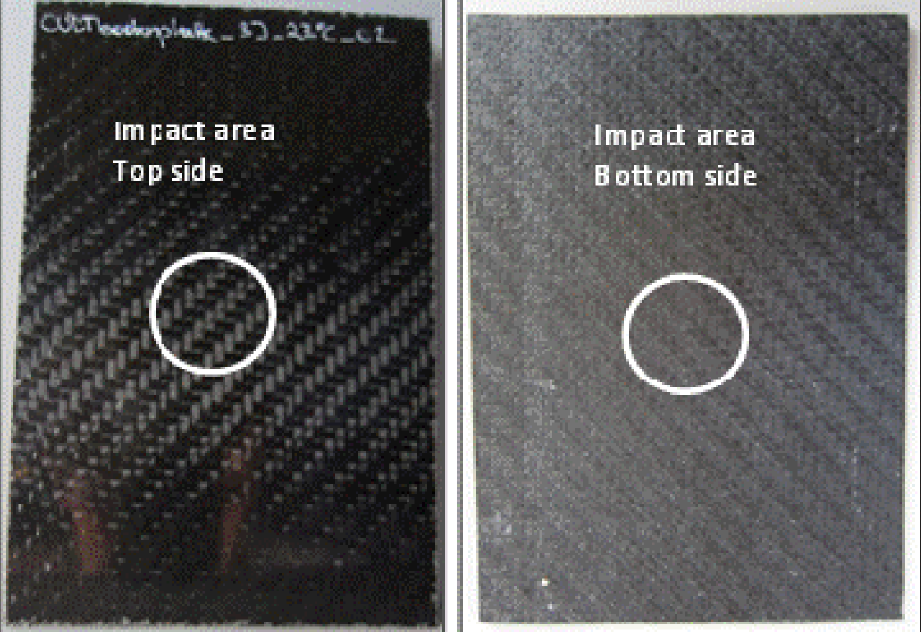
Figure 12. Visual failure detection for an impact energy of 3 J; ( left ) top side up; and ( right ) bottom side